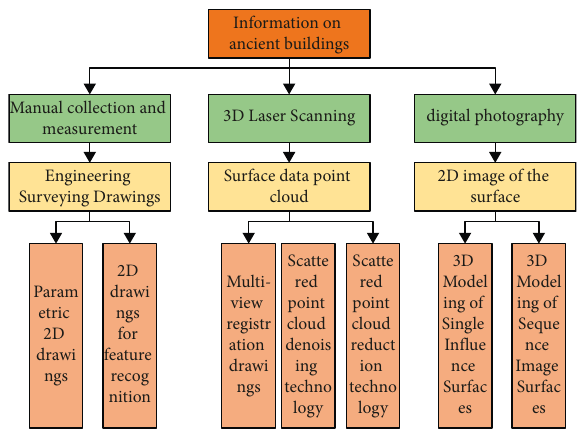
Figure 1: Key technologies of digitization and 3D modeling of ancient